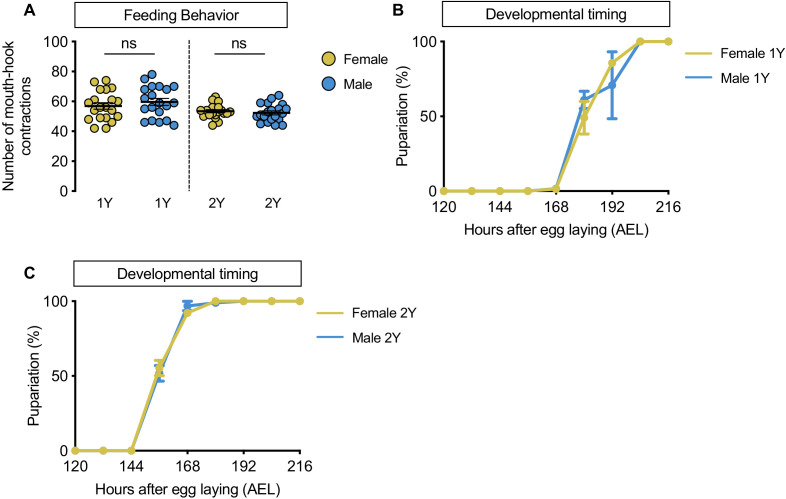
No sex difference in food intake or time to pupation.(A) There was no significant difference in mouth hook contractions between w1118 control male and female larvae raised on a diet containing a widely used protein content (1Y) (p=0.3965; Student’s t test), or a protein-rich diet (2Y) (p=0.5175; Student’s t test). n = 20 biological replicates. (B) There was no sex difference in the time to pupation between w1118 control male and female larvae when cultured on 1Y. n = 79–93 pupae. (C) There was no sex difference in the time to pupation between w1118 control male and female larvae when cultured on 2Y. n = 87–94 pupae. ns indicates not significant; error bars indicate SEM.